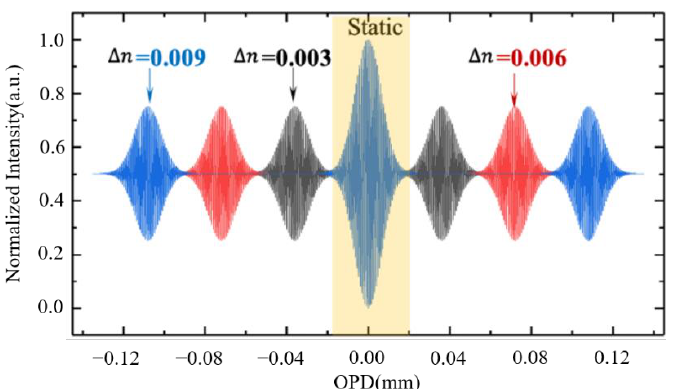
Figure 2. The normalized distribution of the optical signals on the straight waveguide L 5 , the symmetrical distributions on both sides of OPD = 0 correspond to ∆ n = 0.003 (black), 0.006 (red), and 0.009 (blue).